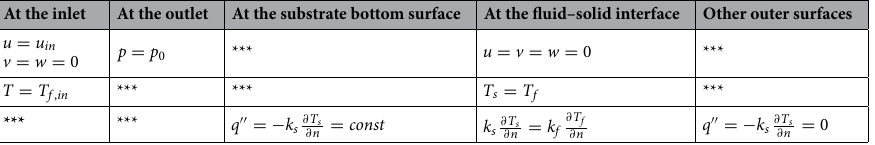
At the inlet At the outlet At the substrate bottom surface At the fluid–solid interface Other outer surfaces u = u in = p 0 *** u = v = w = v = w = 0 p